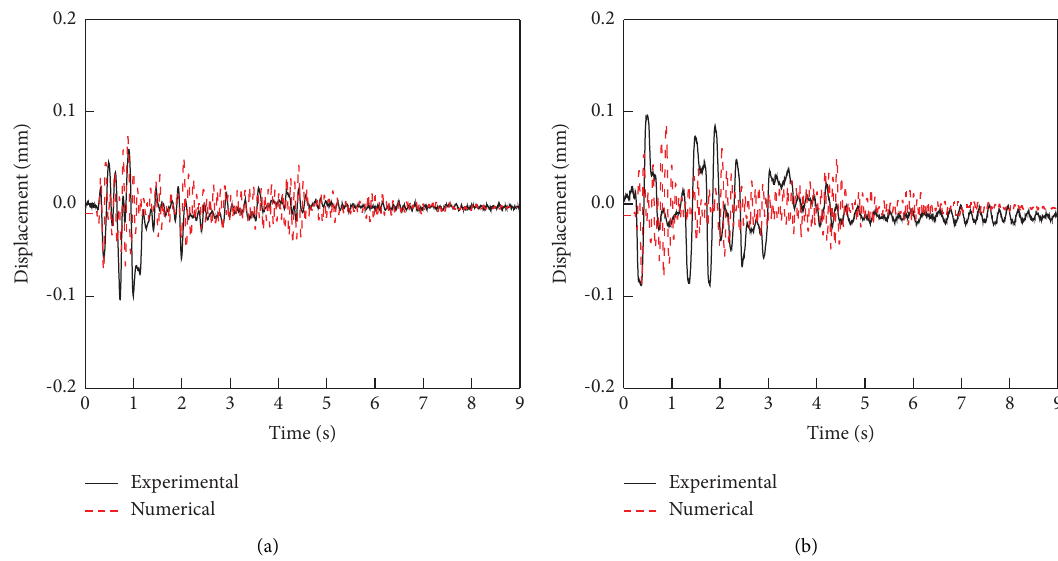
Figure 14: Comparison between testing and calculation results of fxed bearing (6#) for (a) x direction and (b) y direction. Table 9: Comparison of maximum displacement of typical bearings (under 0.45 g) for the experimental test and FE model (mm). Earthquake direction Bearing number x direction ( x p